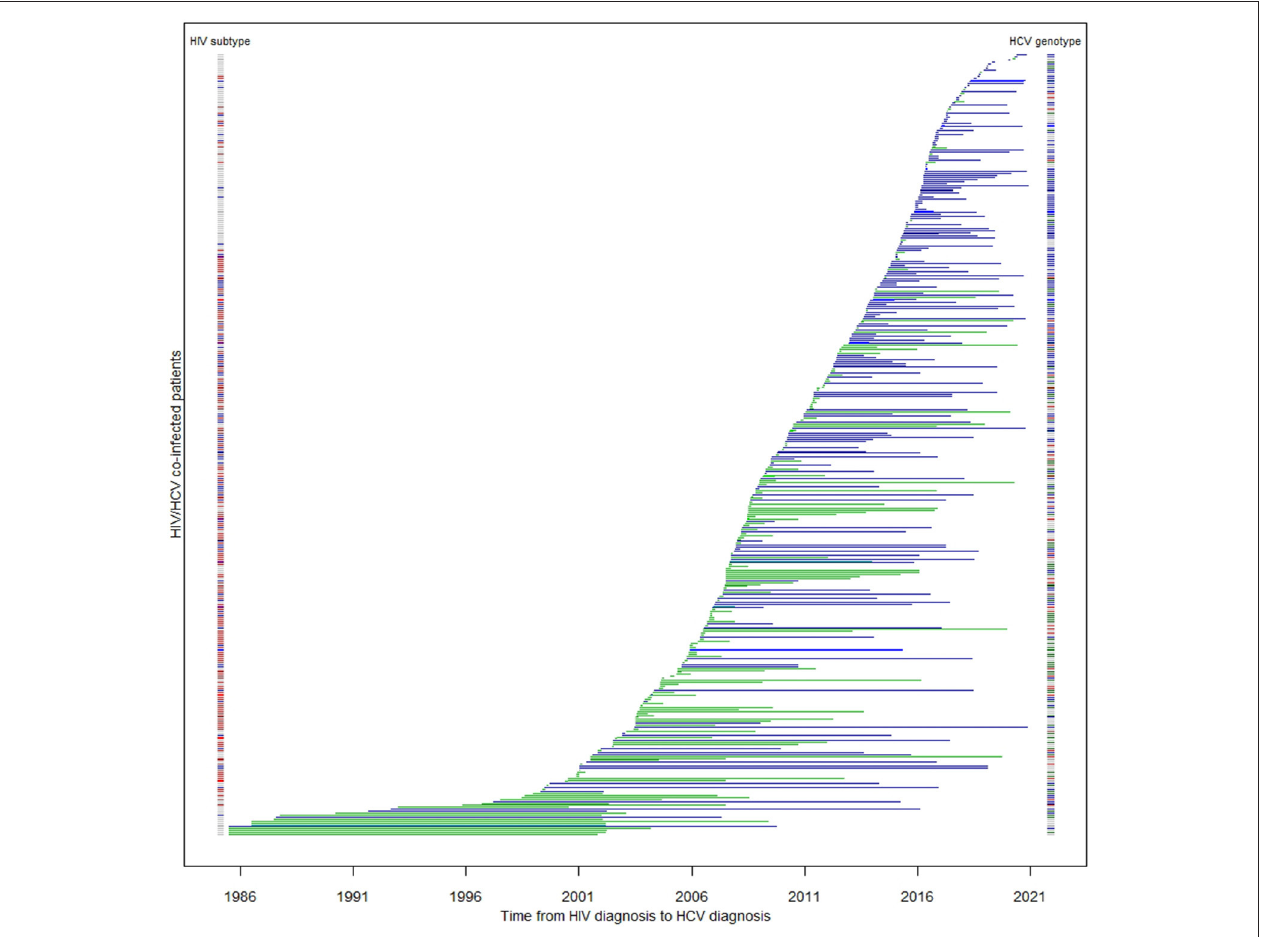
FIGURE 2 | Duration between HIV and HCV diagnoses among co-infected patients ( N = 413). Each horizontal line represents a patient’s time to HCV serconversion since HIV diagnosis. Blue lines are MSM; green lines are non-MSM. The color band on the left denotes HIV subtype of the corresponding patient: blue: subtype B; red: subtype CRF01_AE; other subtypes: brown; unknown: gray. The color band on the right denotes their HCV genotype: green: 1; brown: 2; blue: 3; red: